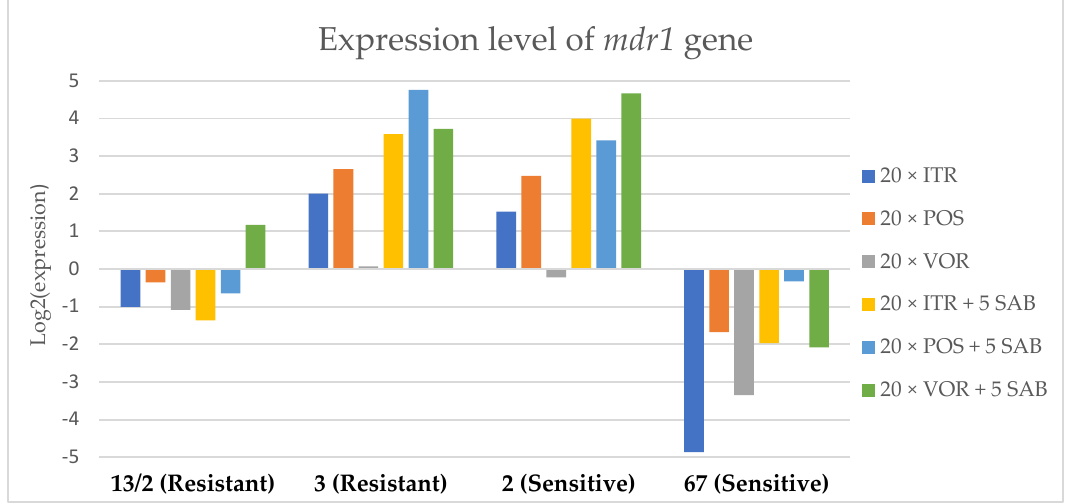
Figure 3. Expression levels of mdr1 after culturing isolates on SAB with ITR, POS and VOR additions, followed by 5 times culturing on only SAB.